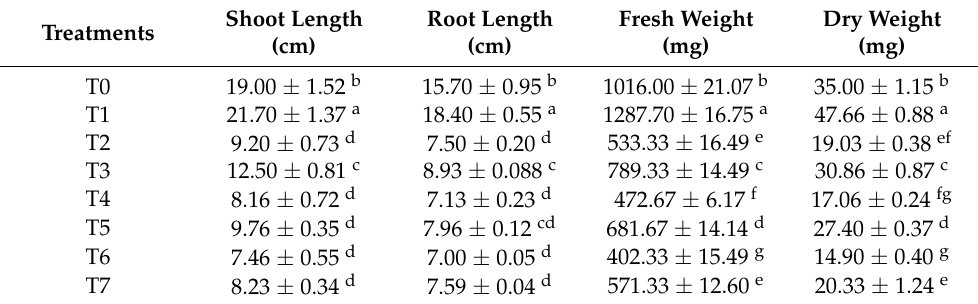
Table 3. Effect of chromium stress and B. cereus inoculation on plant growth and biomass of B. nigra L. Shoot Length Root Length Fresh Weight Dry Weight Treatments (cm) (cm) (mg) (mg) T0 19.00 ± 1.52 b 15.70 ± 0.95